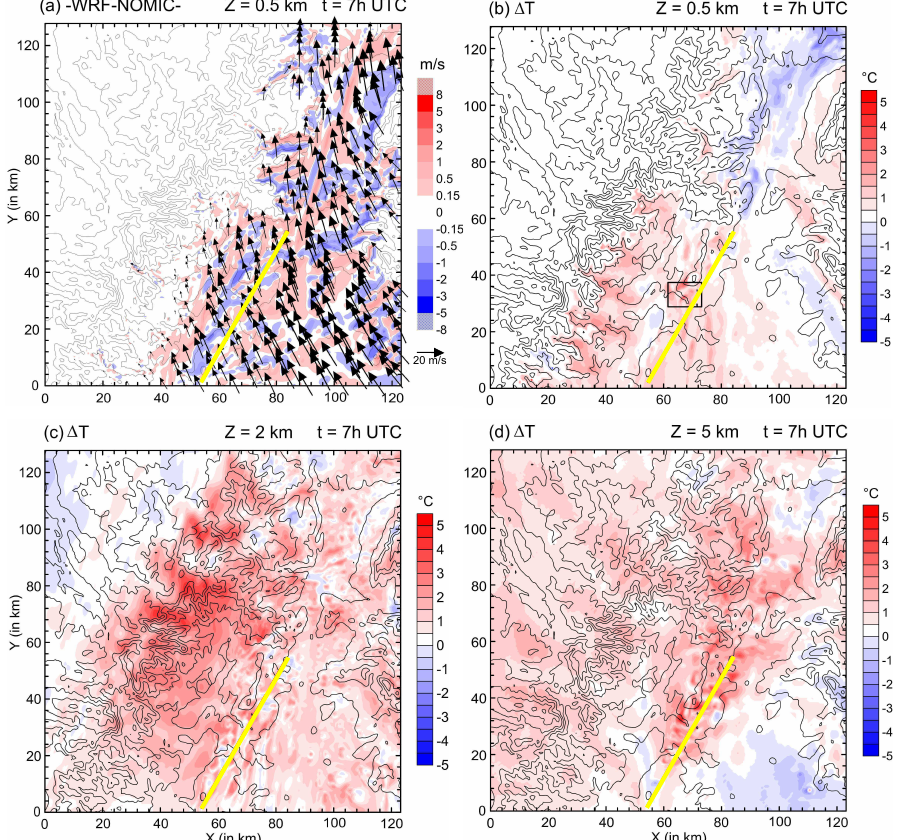
Figure 10. Horizontal and vertical wind components simulated over the innermost domain in WRF-NOMIC below the cloud system (at 0.5 km height) and at 7:00 UTC ( a ) and temperature difference ( ∆ T ) between WRF-MORR and WRF-NOMIC at 0.5 km ( b ) and at two other altitudes: 2 km and 5 km ( c , d ), that is, the altitudes where the amount of the condensed water phases are the highest (see Figure 7). The positive values indicate that the temperature is warmer in WRF-MORR than in WRF-NOMIC. The yellow segment indicates the position of the low-level wind convergence simulated in WRF-MORR at 07:00